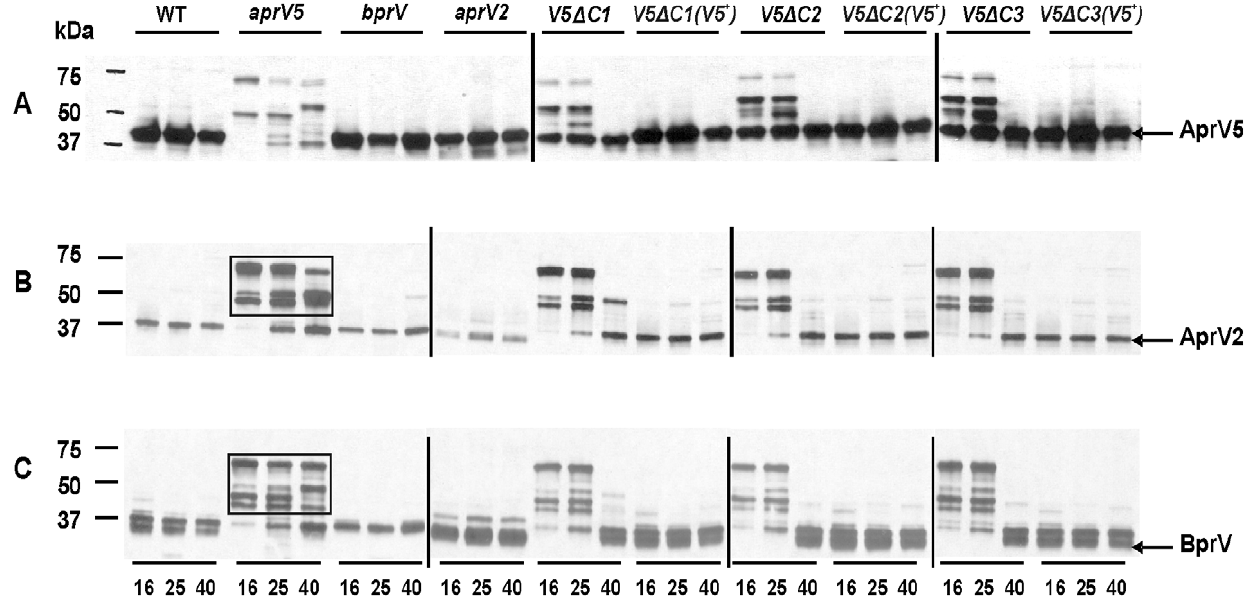
Figure 5. Western immunoblotting of wild-type and mutants with specific protease antisera. Concentrated culture supernatants (3 m g) from 16 h, 25 h and 40 h (from left to right ) TAS growth of the wild type strain VCS1703A (WT), the aprV5 D 478–595 strain JIR3947 ( V5 D C1 ), the aprV5 D 503–595 strain JIR3956 ( V5 D C2 ), the aprV5 D 560–595 strain JIR3969 ( V5 D C3 ) and their complemented derivatives of JIR3968 ( V5 D C1(V5 + ), JIR3965 ( V5 D C2(V5 + ) and JIR3978 ( V5 D C3(V5 + ) were separated on 4–15% gradient SDS-PAGE and analysed by Western immunoblotting with ( A ) AprV5 (1:4000)-, ( B ) AprV2 (1:300)- and ( C ) BprV (1:4000)- antisera. The aprV5 mutant JIR3756 ( aprV5 ), the aprV2 mutant JIR3743 ( aprV2 ) and the bprV mutant JIR3928 ( bprV ) were included as controls. The two groups of larger proteins in the aprV5 preparation are boxed.